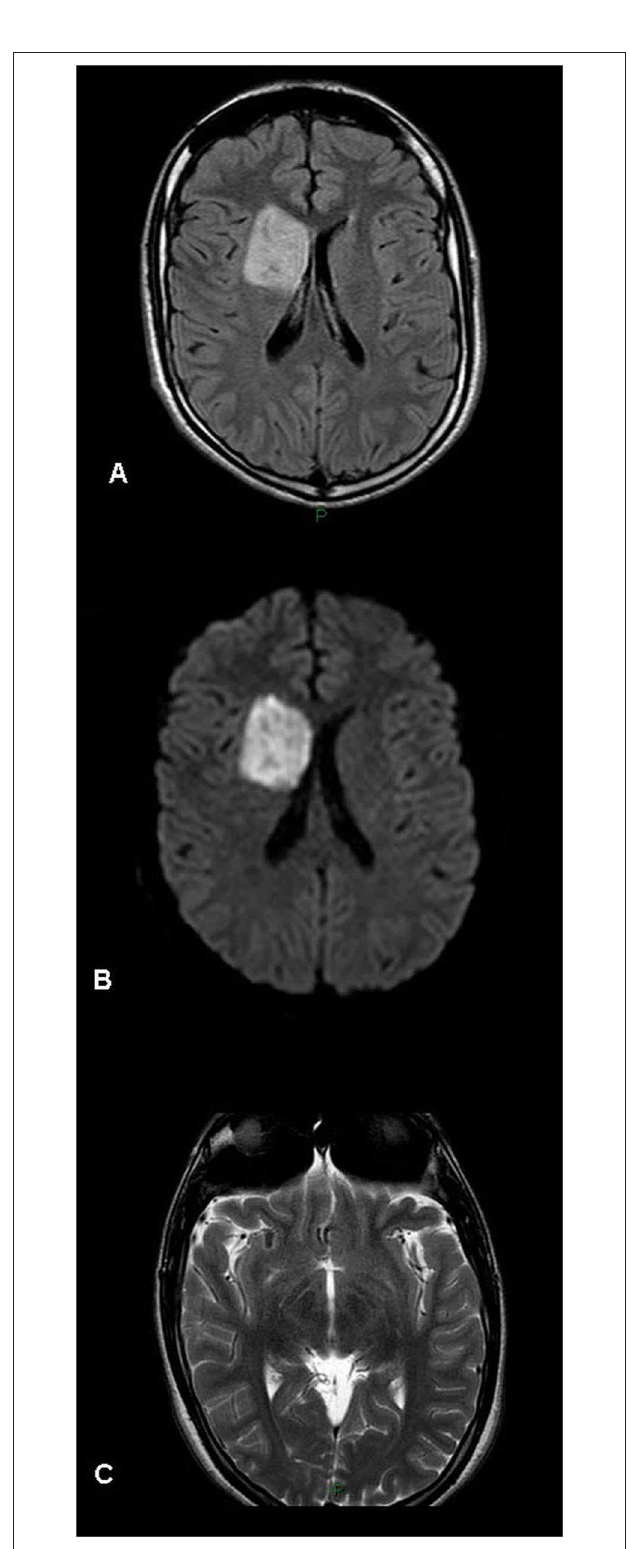
FIGURE 1 | Acute right basal ganglia infarct – magnetic resonance (MR) findings (patient 7, Table 1 ). (A) FLAIR. (B) DWI. (C) T2 imaging. Right acute basal ganglia infarct with right M2 segment pseudoaneurysm visualized on the T2 weighted imaging, consistent with the patient history of Marfan